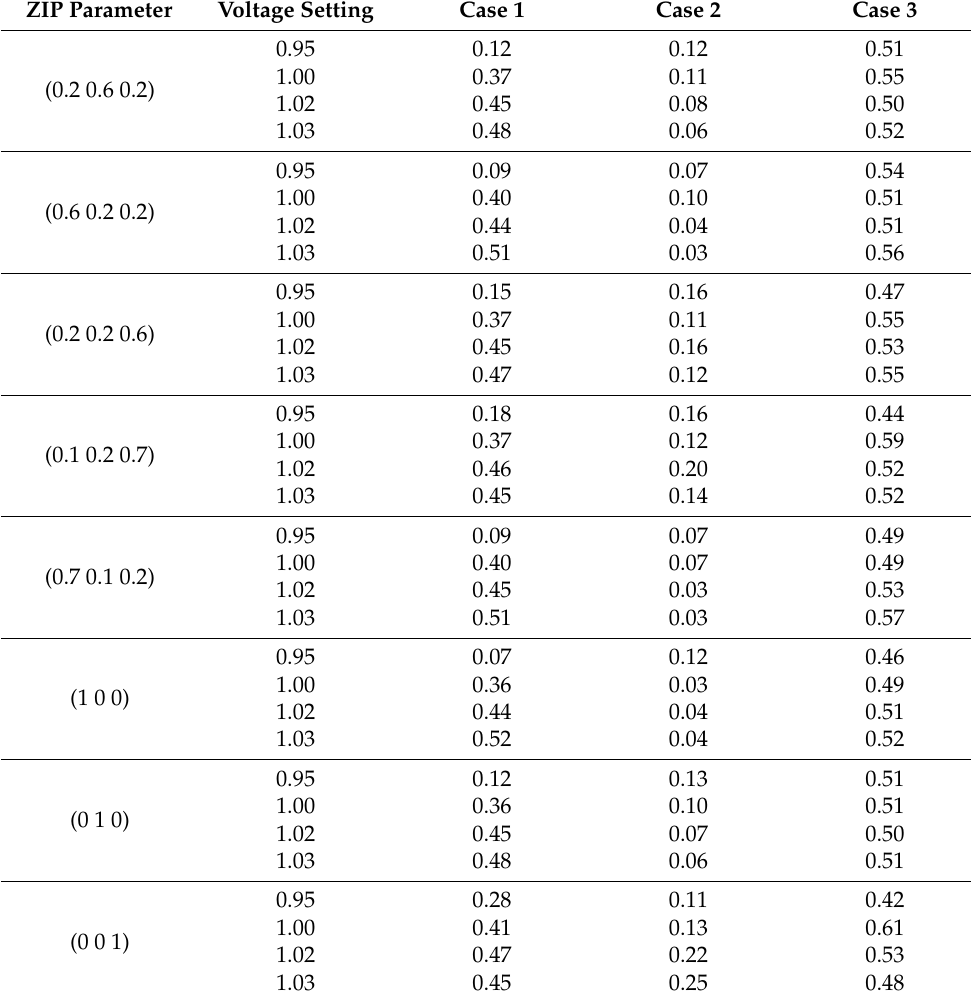
Table 11. RMS error for active power loss estimation for function 2 for IEEE-34 bus system.